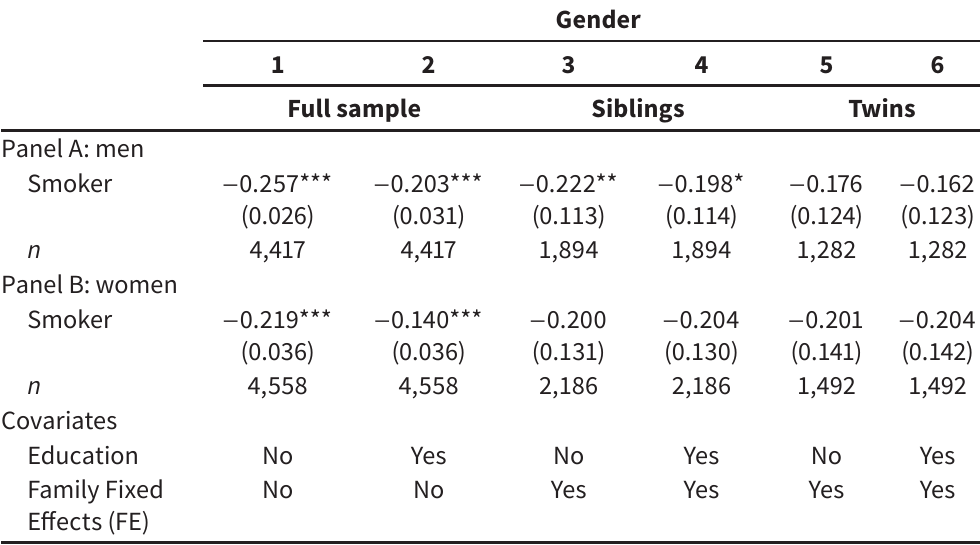
Does the earnings impact vary by gender?